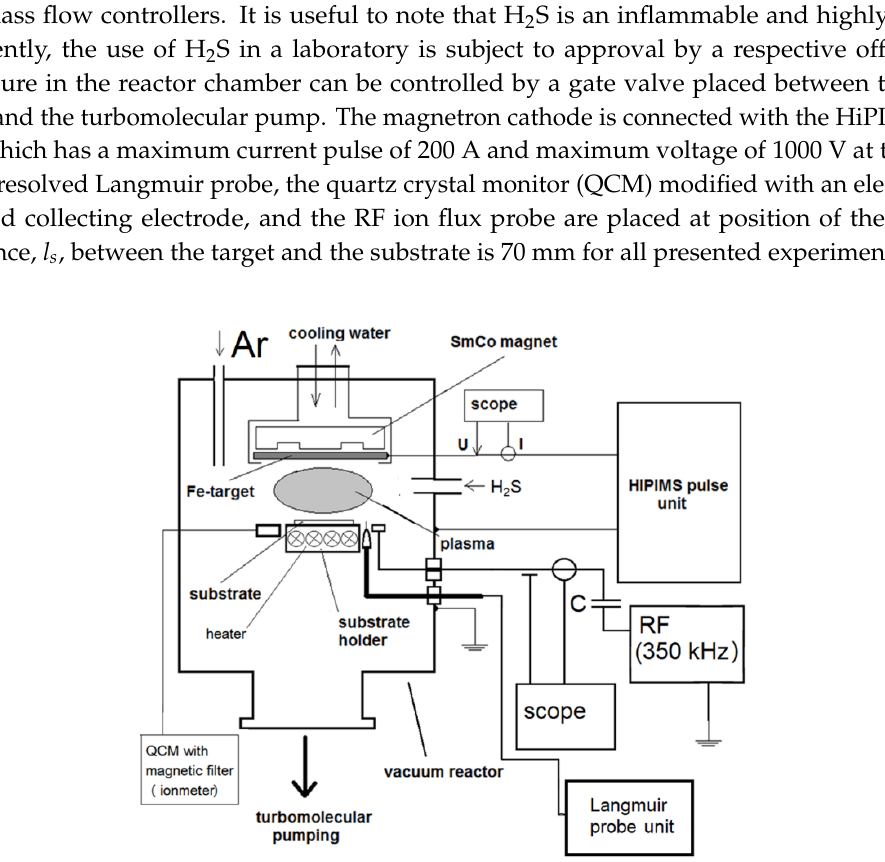
Figure 1. Experimental setup of reactive high-power impulse magnetron sputtering system (HiPIMS) deposition system in Ar + H 2 S gas mixture.